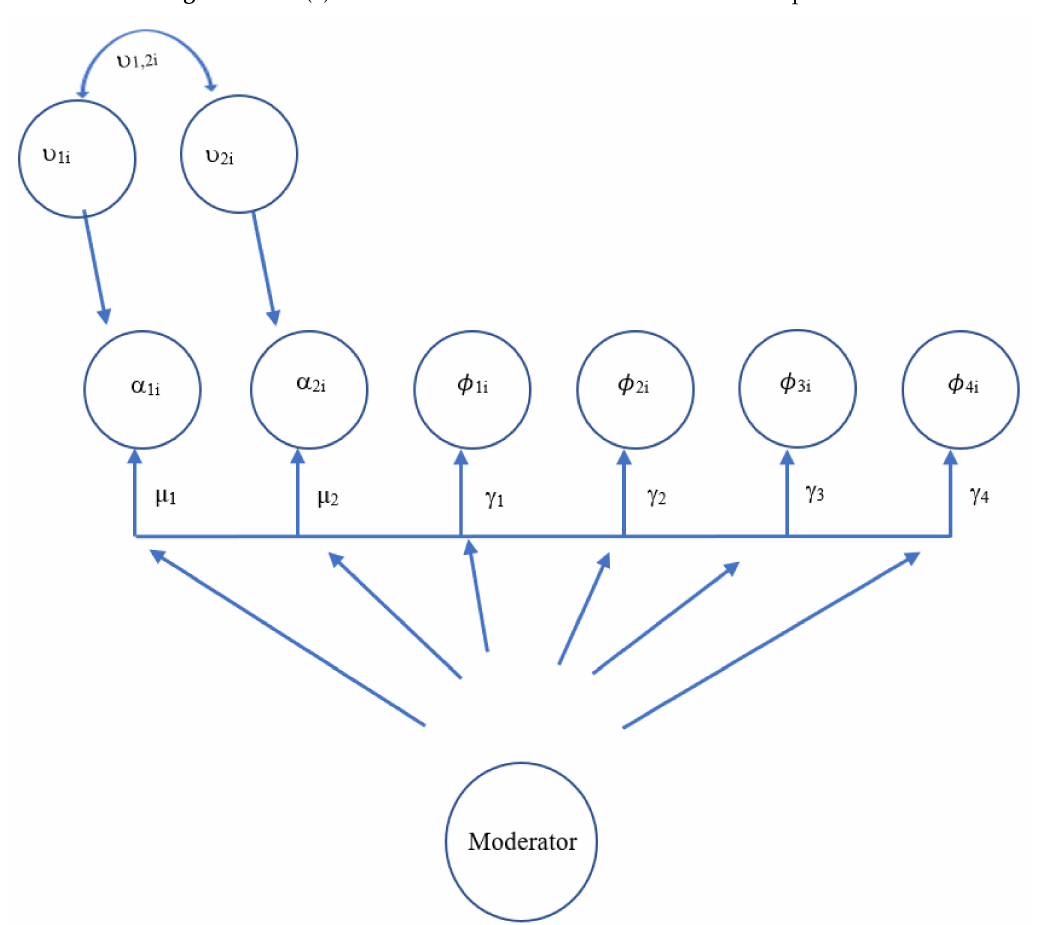
Figure 5. VAR(1) Model: Moderation of the Between-Person Model (Within-Person Means, Autoregressive Parameters, and Cross-Lagged Parameters). Note. Figure 5 depicts the moderation of the between components of the study model. α represents person-specific intercepts for physical activity ( α 1i ) and pain ( α 2i ); fixed effects ( µ 1 , µ 2 ); υ 1,2i represents random effects related to physical activity and pain; φ 1-4i represents autoregressive parameters and cross-lagged regression effects; γ 1-4 represents fixed effects of autoregressive and cross-lagged regression